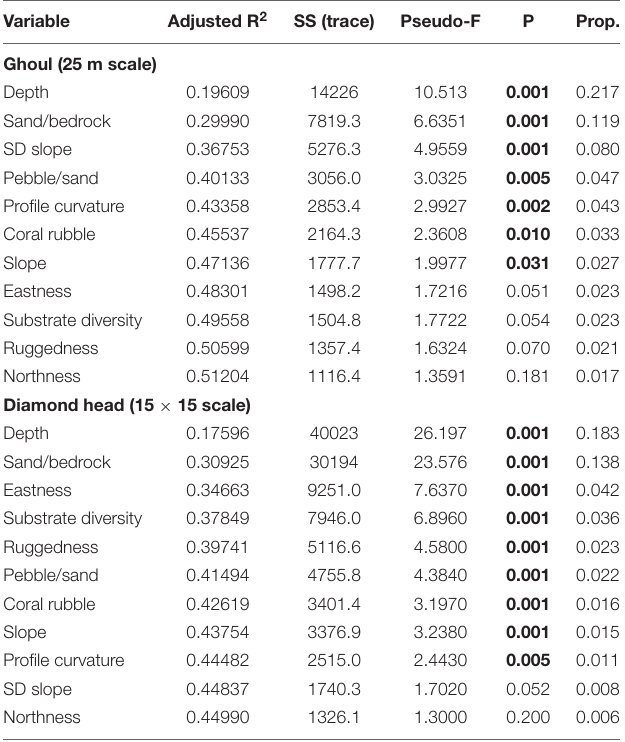
TABLE 5 | Sequential test results of the best DistLM models for each